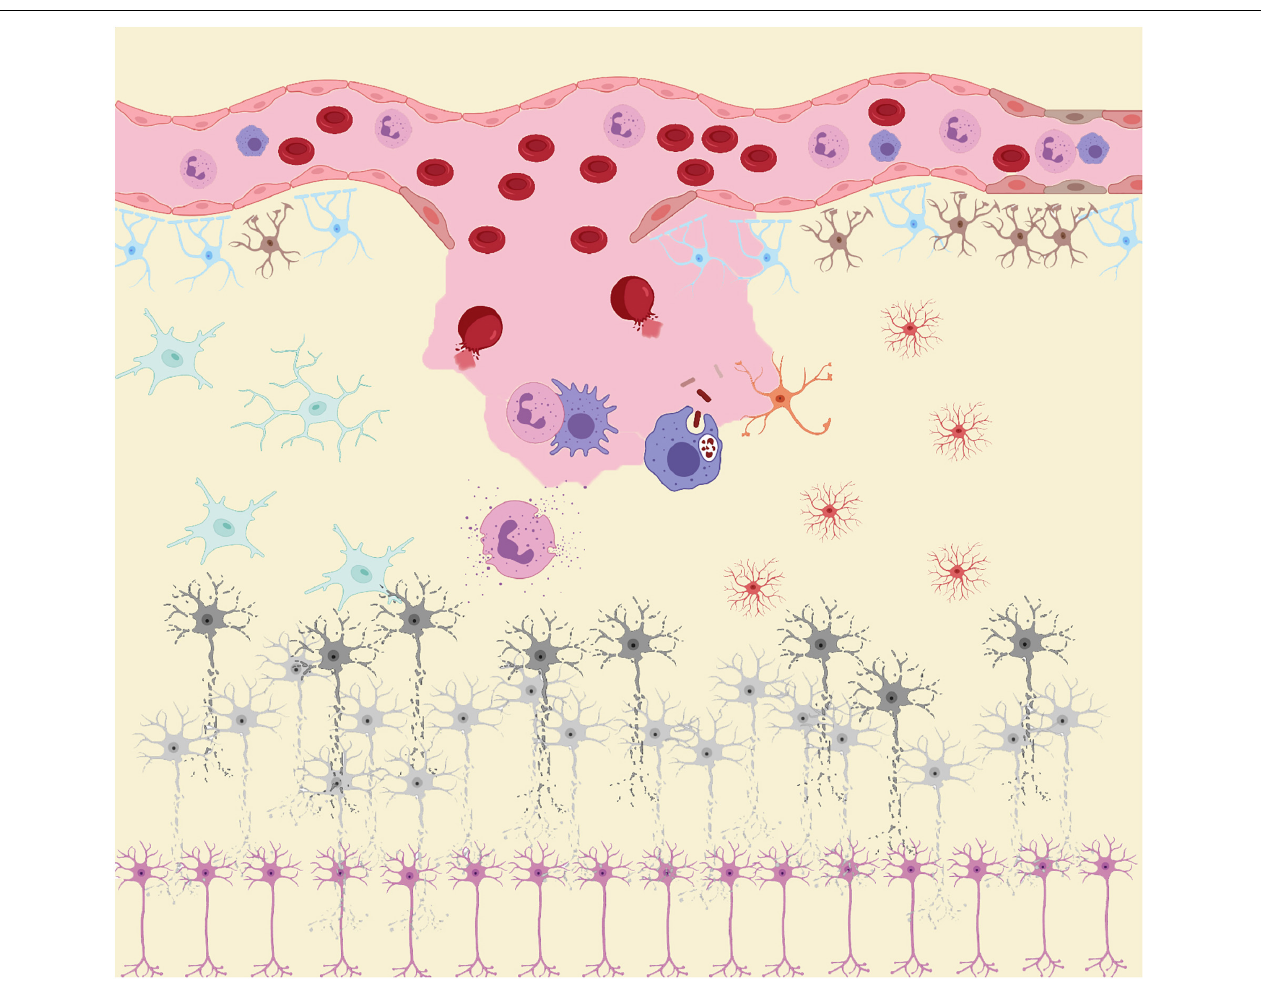
FIGURE 1 | After subarachnoid hemorrhage (SAH), blood components enter the subarachnoid space. RBC rupture hemoglobin and its metabolites, together with other damage-associated molecular patterns (DAMPs), act as inducers of the secondary inflammatory response after SAH to activate the innate immune cells (microglia and astrocytes) in central nervous system (CNS). Subsequently, immune cells such as neutrophils and macrophages in the peripheral circulation infiltrate into the injured site under the action of chemokine recruitment. These peripheral immune cells, together with innate immune cells in CNS, act as the carriers of secondary inflammation after SAH, releasing large amounts of pro-inflammatory cytokines and peroxides causing damage to neurons. Under the influence of these inflammatory products and peroxides, neurons gradually appear cell dysfunction and even